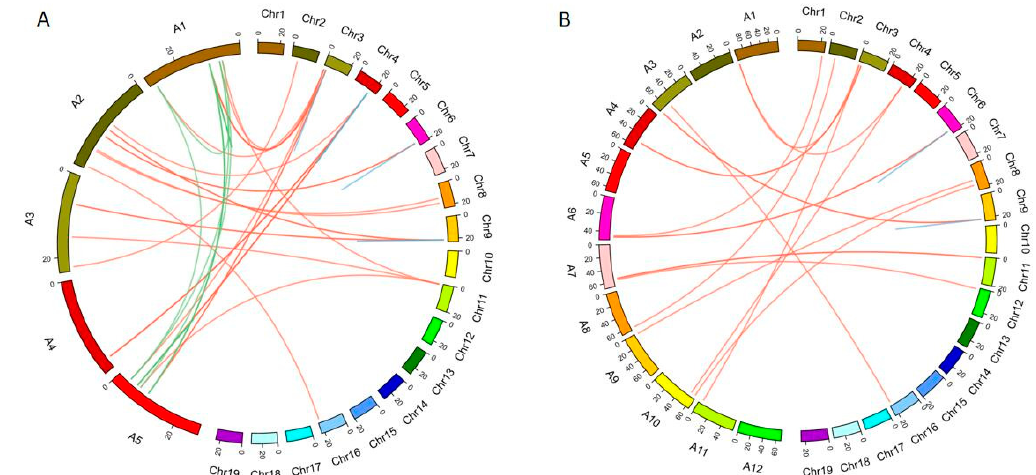
Figure 4. Analysis of paralogous SAUR genes and their orthologues in grape, Arabidopsis and tomato. ( A ) Analysis of paralogous and orthologues in grape (Chr1–Chr19) and Arabidopsis (A1–A5). Blue lines represent paralogous SAUR genes in grape. Green lines represent paralogous SAUR genes in Arabidopsis . Red lines represent their orthologous SAUR genes. ( B ) Analysis of paralogous and orthologues in grape (Chr1–Chr19) and tomato (A1–A12). Blue lines represent paralogous SAUR genes in grape. Red lines represent their orthologous SAUR genes. Relationships of orthologous and paralogous SAUR genes among grape, Arabidopsis and tomato were drawn by Circos 0.69.6 (http://circos.ca/, access on 23 May